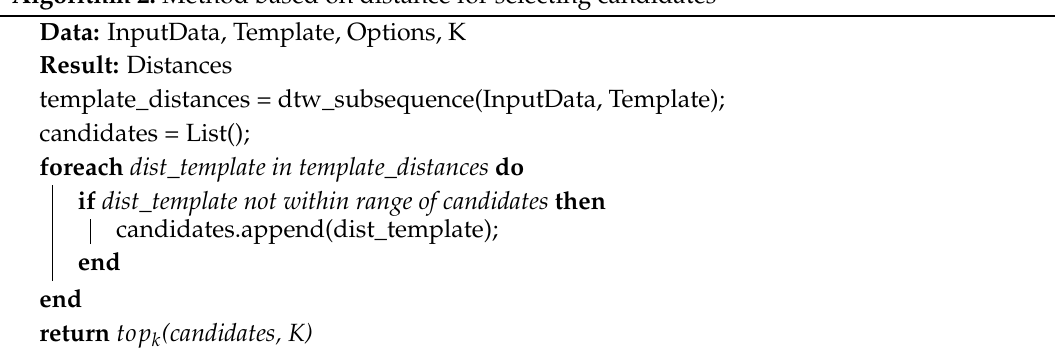
Algorithm 2: Method based on distance for selecting